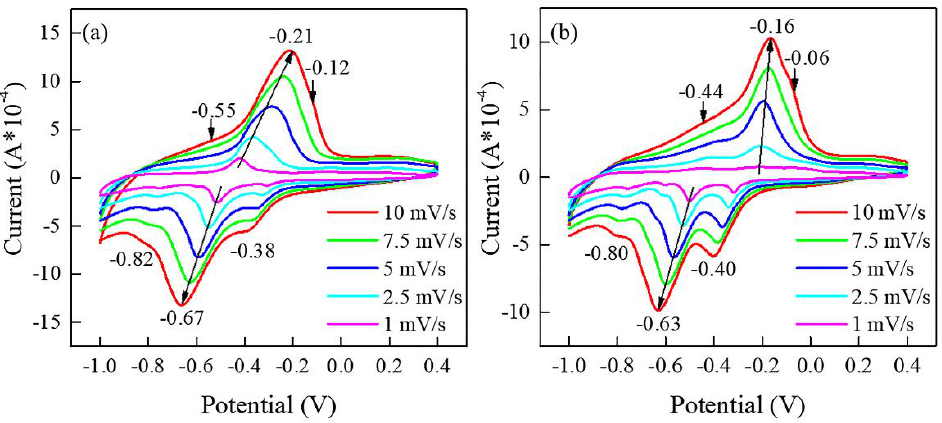
Figure 5. CV curves of the film - working electrodes at different scan rates: N − 400 ( a ); N − 450 ( b ). Figure 6 represents the fitted straight lines of the peak anode and peak cathode cur- rents, respectively, versus the open square v 1/2 for different sweep rates. The Li + diffusion coefficient in the film electrode is calculated according to the Randles – Sevcik equation.